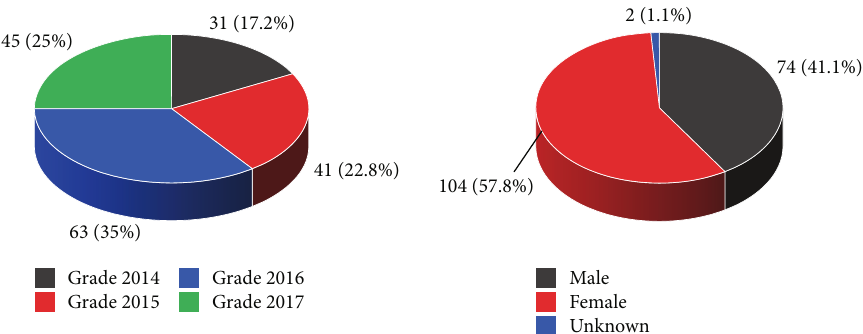
Figure. 4: The statistical analysis of samples.